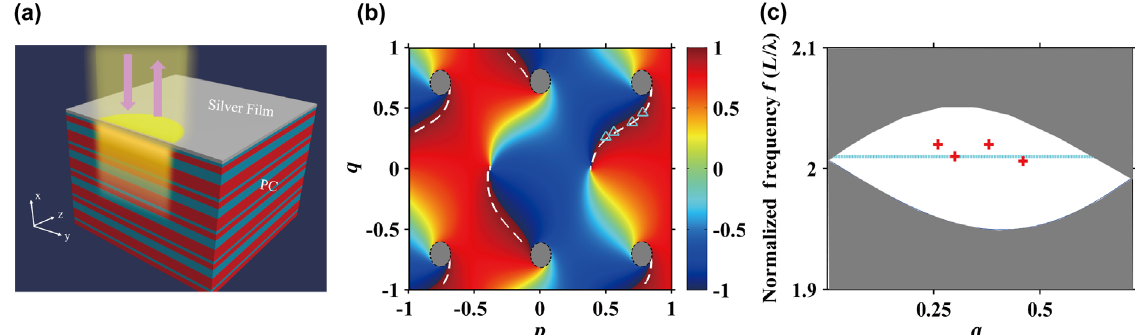
FIG. 4. The “ Fermi arc ” in the parameter space. (a) A sketch shows the structure used in measuring the interface states. Here, the silver slab represents the silver film, blue represents H f O 2 , and red represents S i O 2 . Wave incidents from the silver film side and the interface states are localized in the interface region between the silver slab and the semi-infinite PC. The amplitude of the wave is shown schematically in yellow. (b) The reflection phase of the PCs at the frequency of Weyl points with charge þ 1 with its dispersion shown in Fig. 2(d). The bulk band regions at the working frequency are shaded in gray. The white dashed lines show the trajectories of the interface states of a system consisting of a semi-infinite PC coated with a silver film, where the semi-infinite PC is truncated at the center of the first layer. These interface state trajectories are analogues of Fermi arc states. The triangles mark the p and q values of the four samples in the experiment. (c) The cyan line indicates the working frequency used in (b), and the red crosses label the experimental results. The projection of the bulk band as a function of q is shaded in gray. The number of unit cells is 10, and d a ¼ 0 . 323 μ m and d 0 . 240 μ m for the four PCs in (c). The thickness of layers in these four PCs are given by ð p; q Þ ¼ ð 0 . 50 ; 0 . 26 Þ , (0.56,0.30), b ¼ (0.70,0.38), and (0.78,0.36),